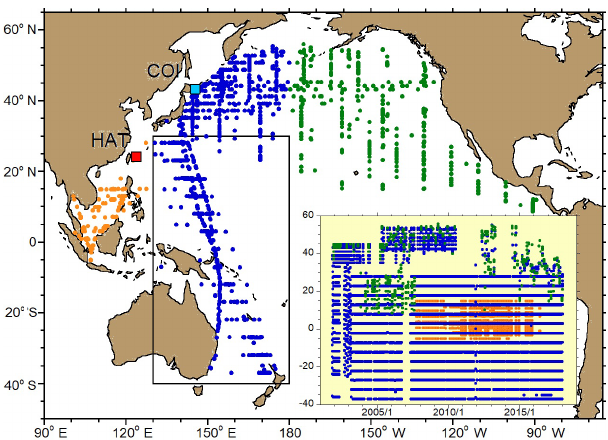
Figure 1. Map showing the air sampling locations in the Pacific region. The light blue and red squares represent the monitoring sta- tions of COI and HAT, respectively. The orange, blue and green cir- cles correspond to the positions where flask samplings were taken aboard cargo ships in southeastern Asia, western Pacific and east- ern Pacific, respectively. The inserted figure shows the time–latitude distribution of onboard flask samples. The flask data from COI, HAT and the regions in the black rectangle (130–180 ◦ E, 40 ◦ S– 30 ◦ N) were used in the budget